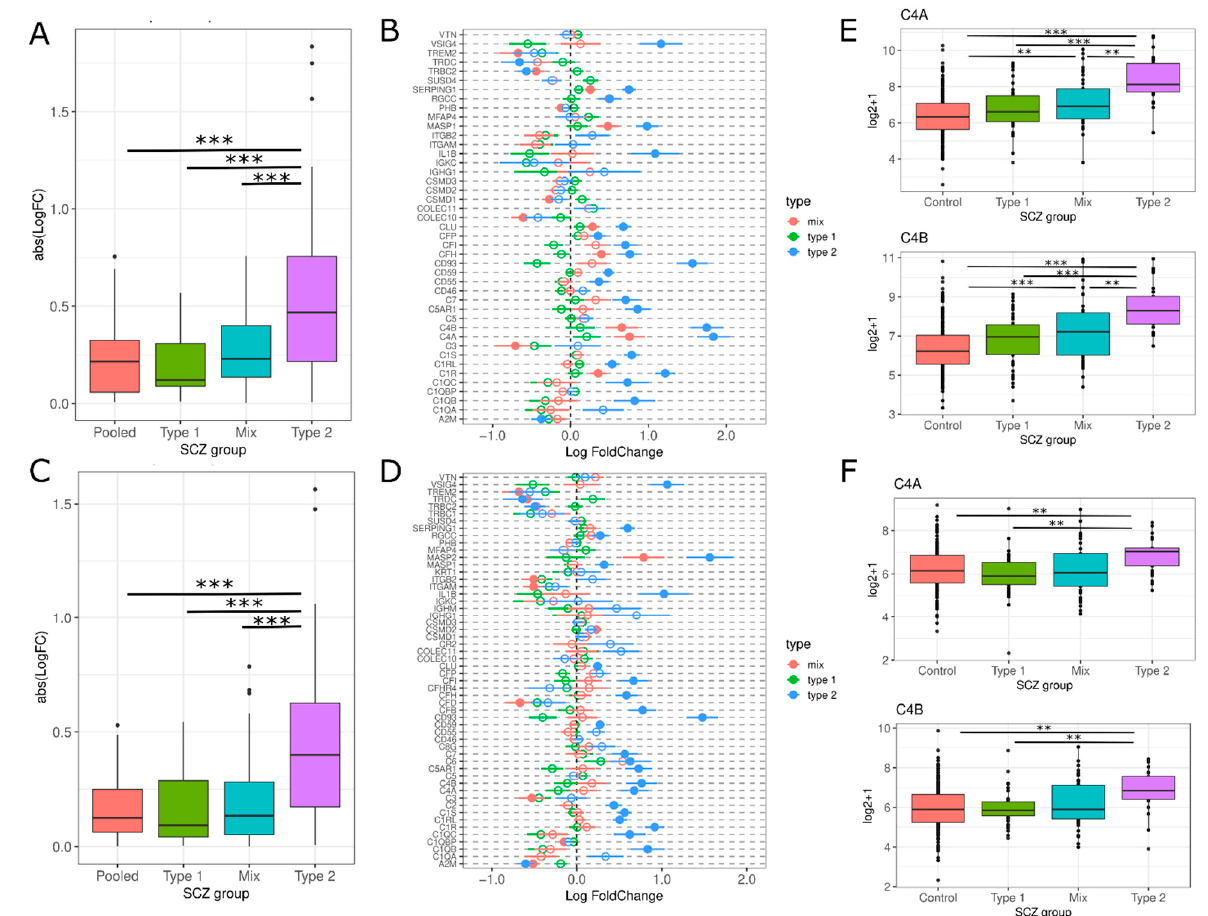
Figure 4. Type 2 has increased upregulation of complement cascade genes. ( A , C ) Absolute LogFC value for complement cascade genes for each SCZ group for polyA and riboZ, respectively *** p -value < 0.001 via Tukey HSD. ( B , D ) LogFC for each SCZ group for subset of genes in polyA and riboZ, respectively. Type 2 (blue), Mix (red), Type 1 (green). Lines indicate standard error. Filled circles = differentially expressed (Benjamini-Hochberg p -value < 0.05), empty circles = not differentially expressed. ( E , F) Boxplot of the log2+1 expression data is shown for each SCZ group: Controls (red), Type 1 (green), Mix (blue) and Type 2 (purple). ** p -value < 0.01, *** p -value < 0.001 via Tukey HSD.